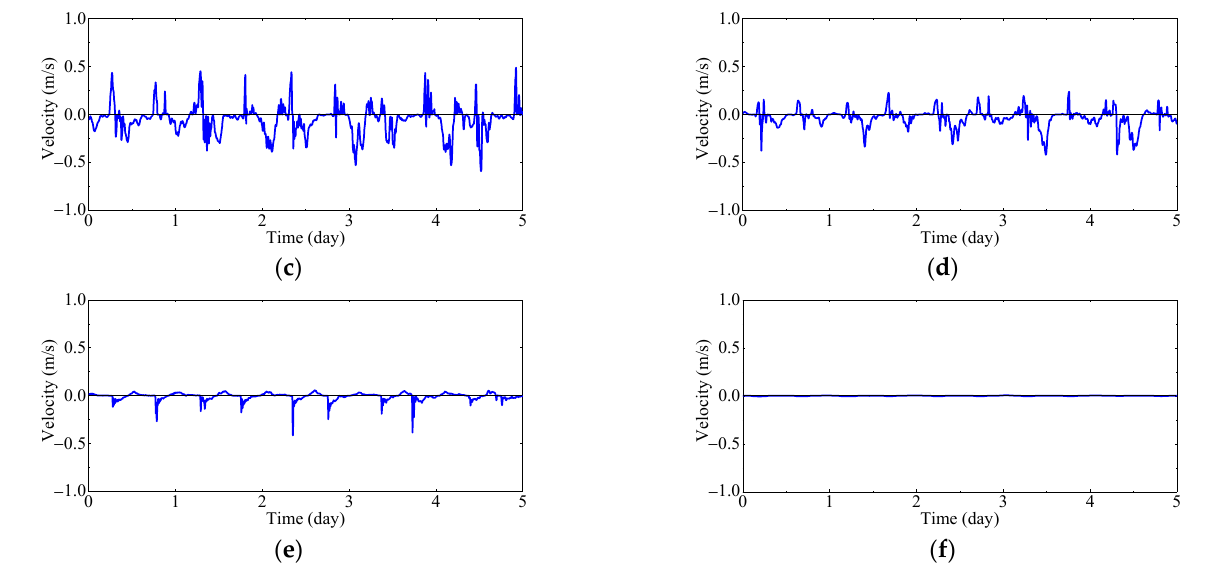
Figure 9. Time series of bottom current for internal wave shoaling on the continental slope, ( a ) de- pression mode; ( b ) depression dominant mode; ( c ) equivalent mode; ( d ) elevation dominant mode; ( e ) elevation mode and ( f ) tidal mode.